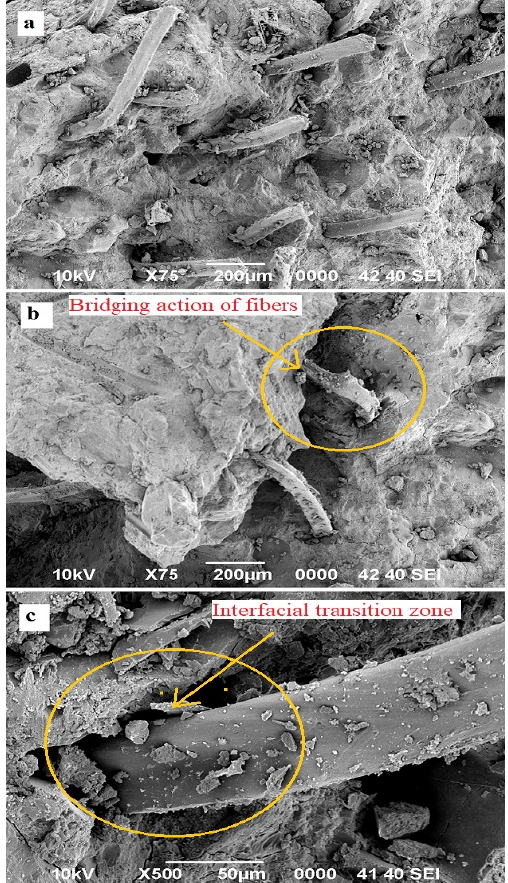
Figure 12. ( a ) Distribution of PP fibres; ( b ) bridging action of fibres; ( c ) the interfacial transition zone between paste and fibre.